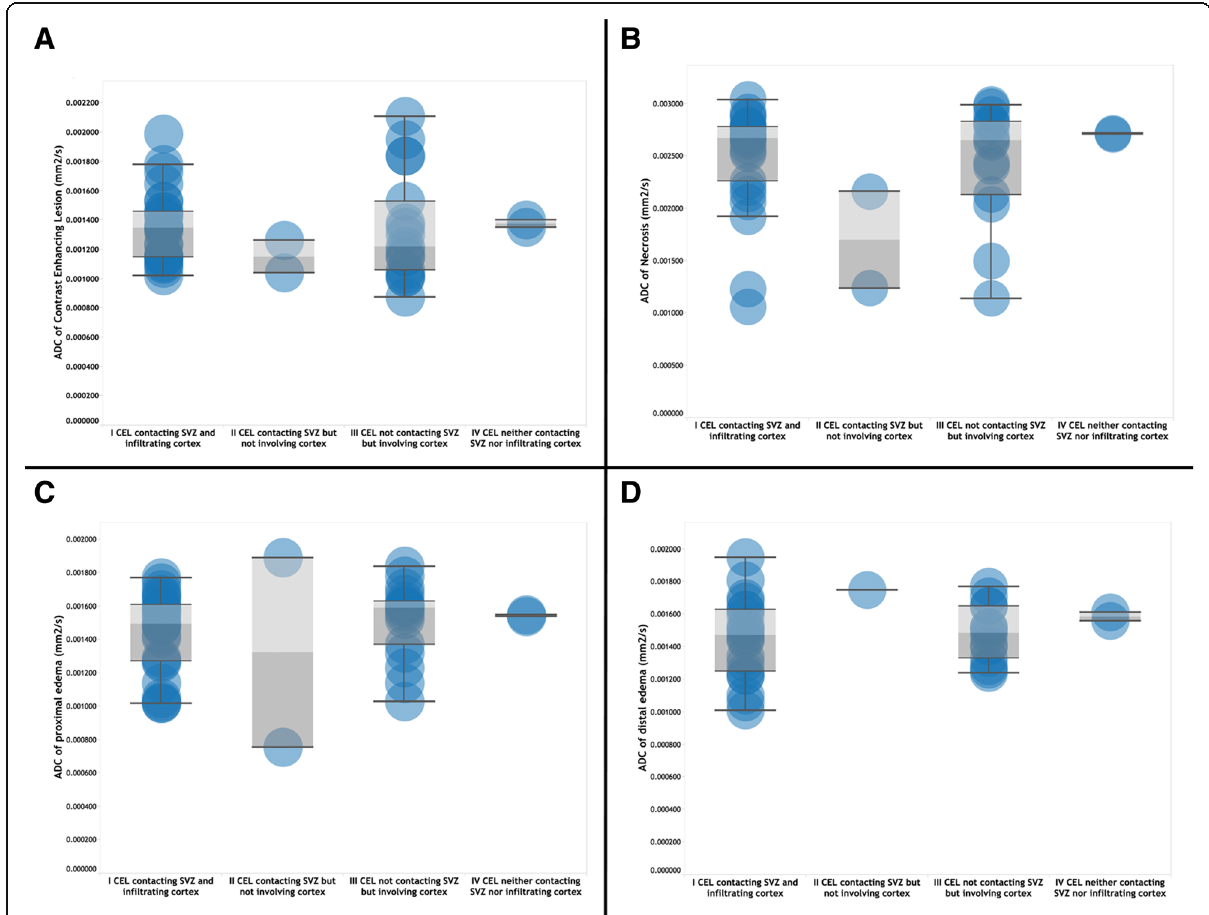
Fig. 2 Distribution of ADC values at each tumour region. a Contrast-enhancing lesion. b Tumour. c Proximal oedema. d Distal